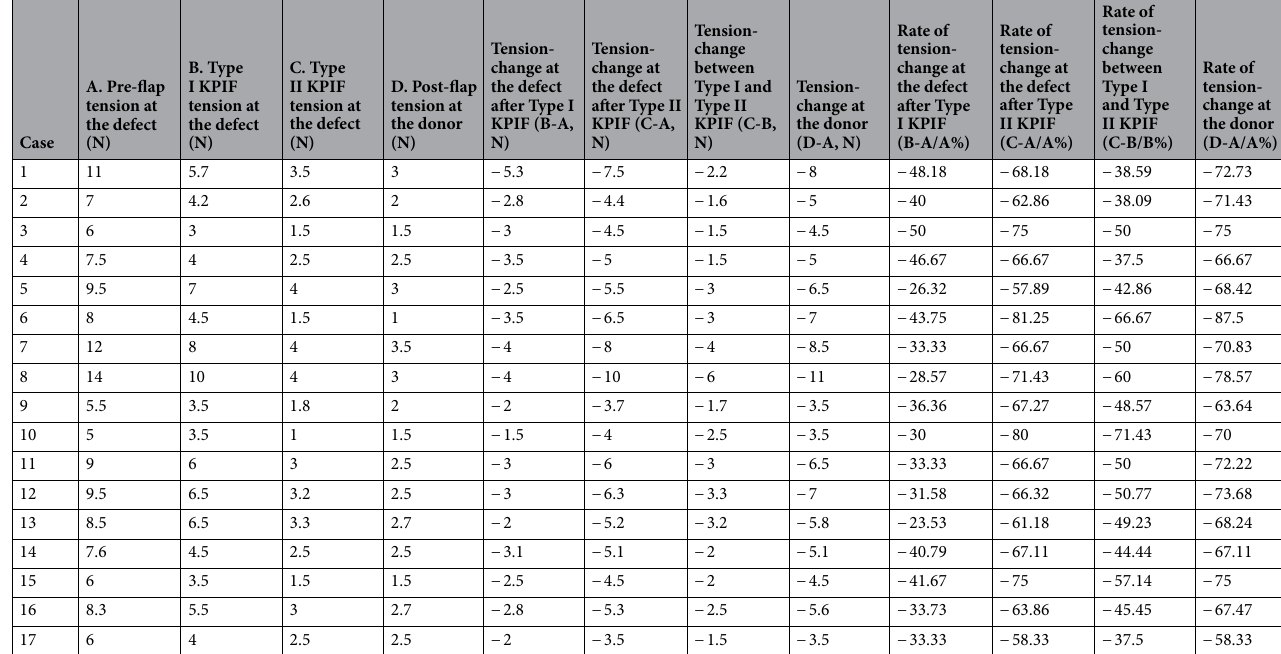
Table 2. Tensiometer data. N Newton, KPIF keystone perforator island flap.